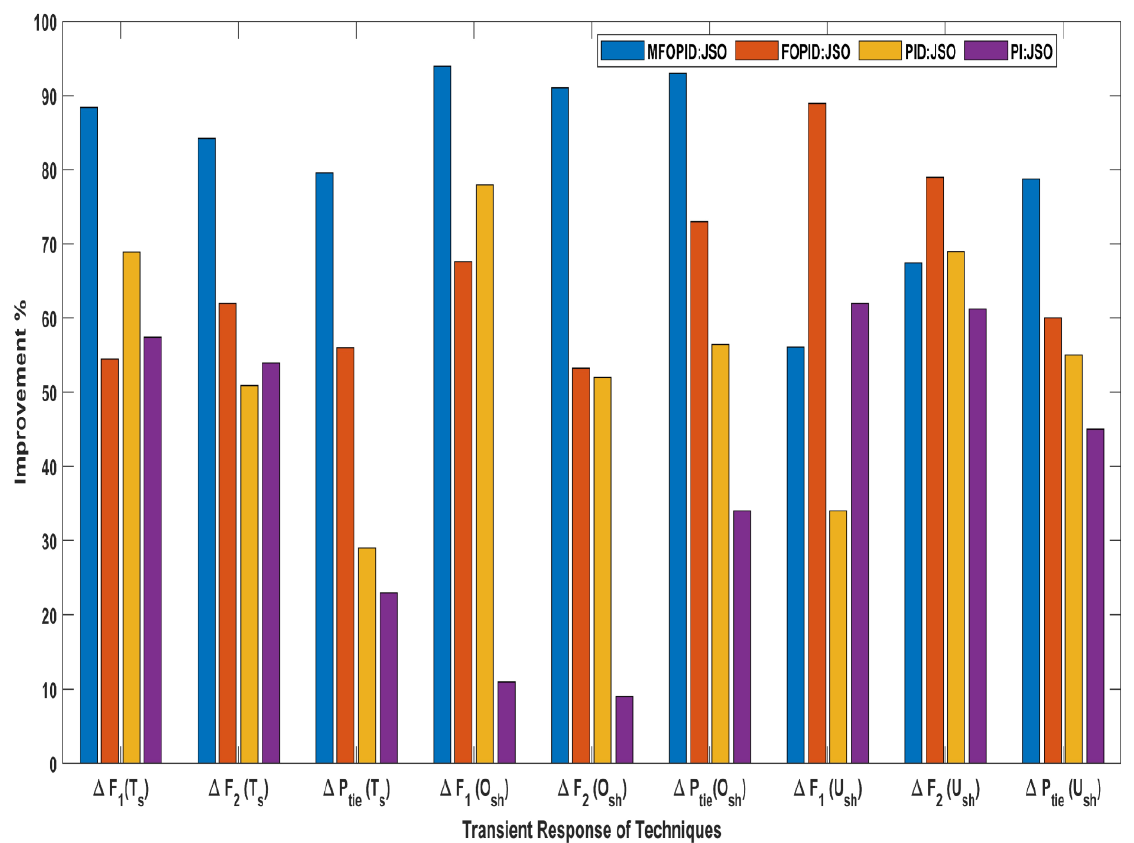
Figure 10. Output response of the PS considering case − 2 for ( a ) ∆ F 1 ; ( b ) ∆ F 2 ; ( c ) ∆ P ite .